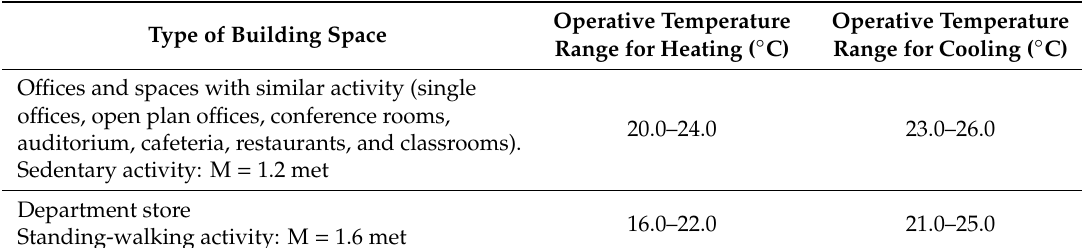
Table 1. Temperature ranges for hourly calculation of cooling and heating energy for some